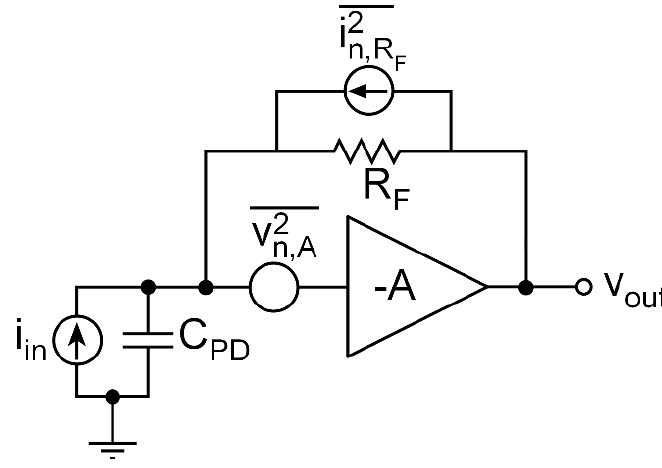
Figure 1. Schematic diagram of a shunt-feedback transimpedance amplifier (TIA), including noise sources.